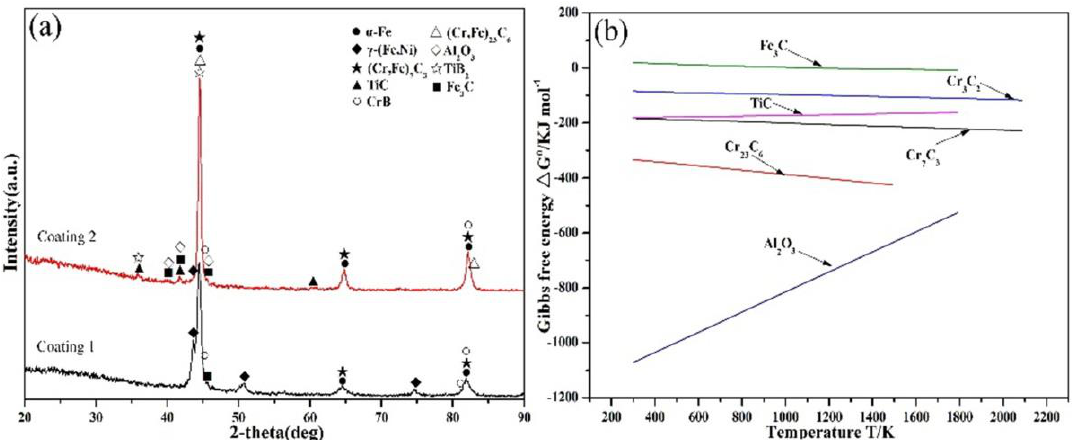
Figure 5. X-ray diffraction ( XRD) patterns of the composite coatings ( a ) and the Ellingham diagram Figure 5. X-ray di ff raction (XRD) patterns of the composite coatings ( a ) and the Ellingham diagram of of Gibbs free energy via the reaction temperature ( b ). Gibbs free energy via the reaction temperature ( b